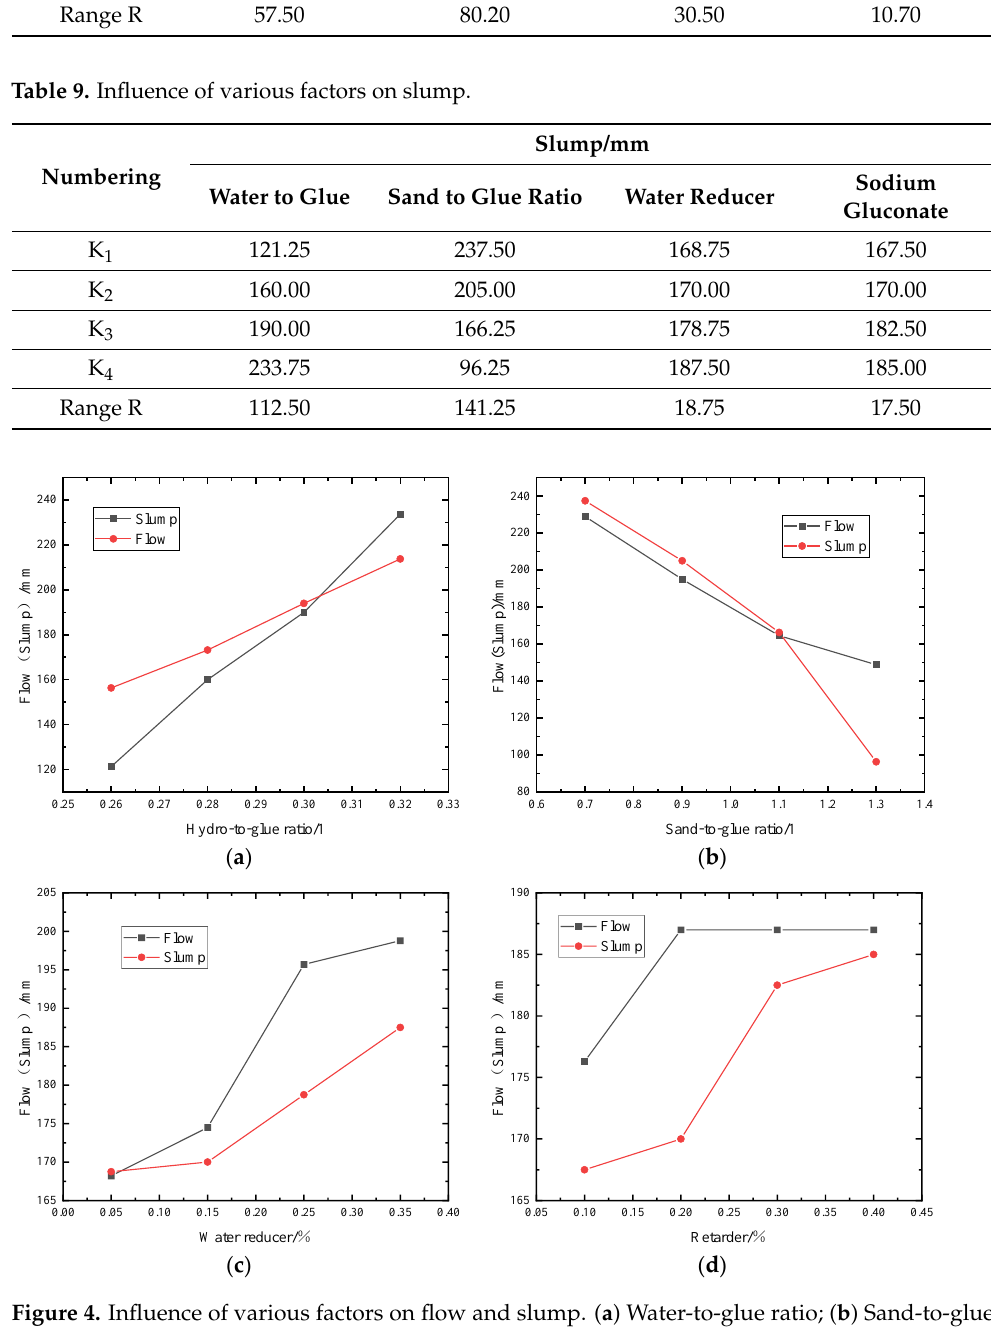
Figure 4. Influence of various factors on flow and slump. ( a ) Water-to-glue ratio; ( b ) Sand-to-glue ratio; ( c ) Water reducer; ( d ) Sodium gluconate. Figure 4c,d indicate that the flow rate and slump slowly increase as the contents of